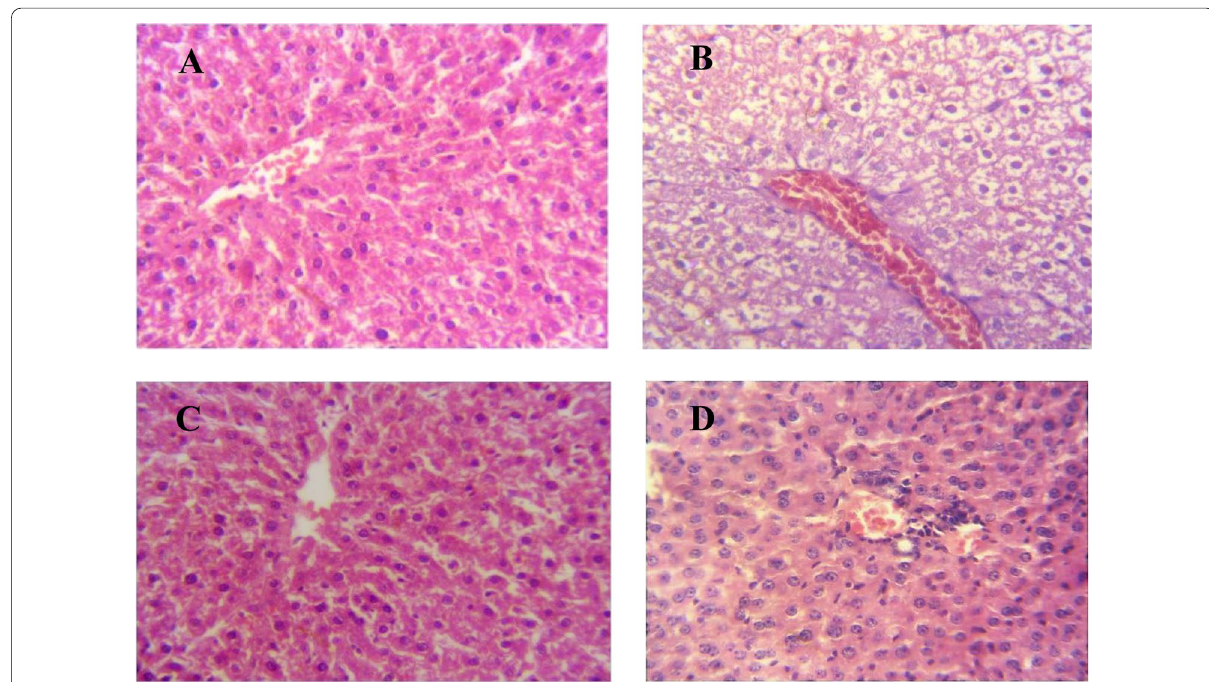
Fig. 5 A micrograph of the liver section by Light microscopy shows: A Control group; A normal hepatic architecture), normal hepatic lobules and hepatocytes B DEN‑treated group; liver section of a rat intoxicated with DEN, showing congested portal vein, different degenerative changes, and necrosis of hepatic tissues around center vein (H.E. X400). C PA oil group; A liver section of a rat receiving PA oil demonstrates normal structure (H&E 400) D DEN PA oil: A liver section of a rat intoxicated with DEN for 6 weeks, then treated with PA oil for another 6 weeks, shows multiple × + dilated blood vessels with moderate leukocyte infiltration